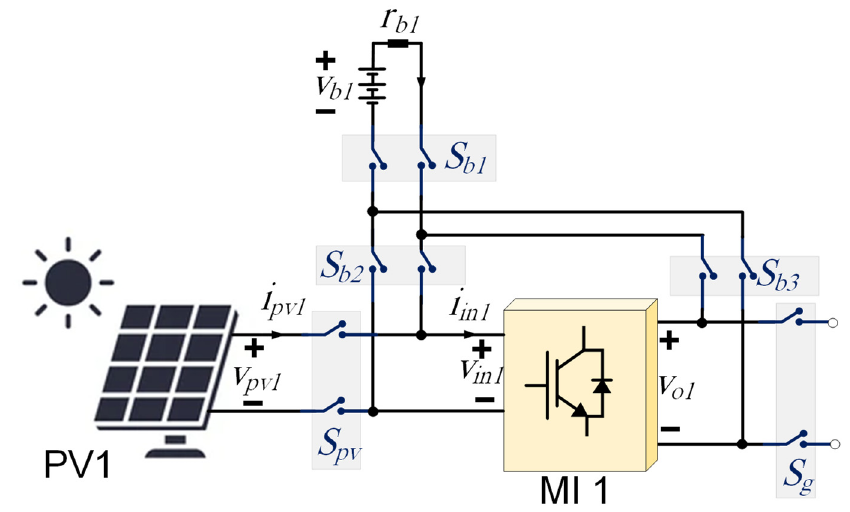
Figure 3. One MI of the proposed MCI with battery packs.